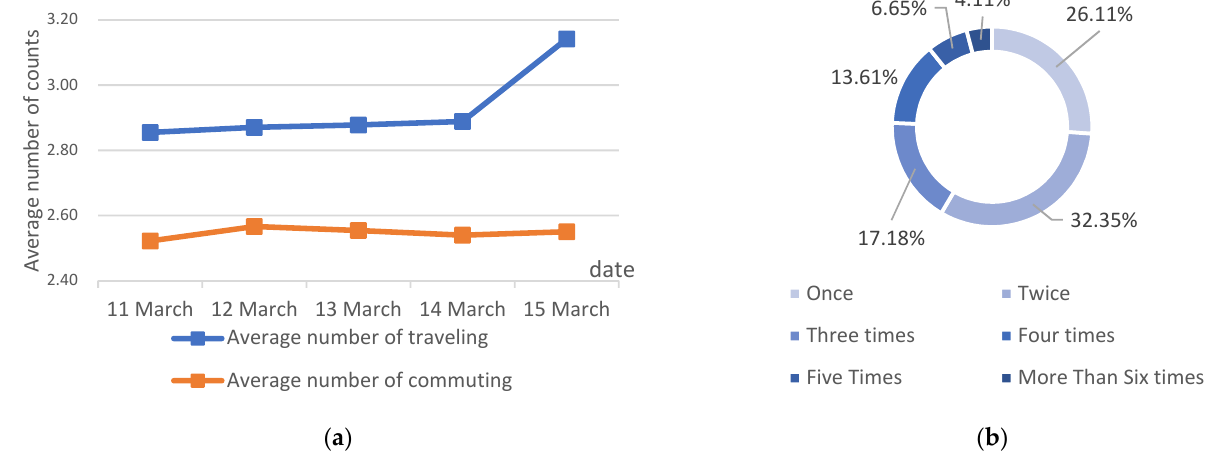
Figure 3. Traveling and commuting frequency. ( a ) Frequency of students traveling and commuting on school days; ( b ) Average number of school commuting as a percentage.